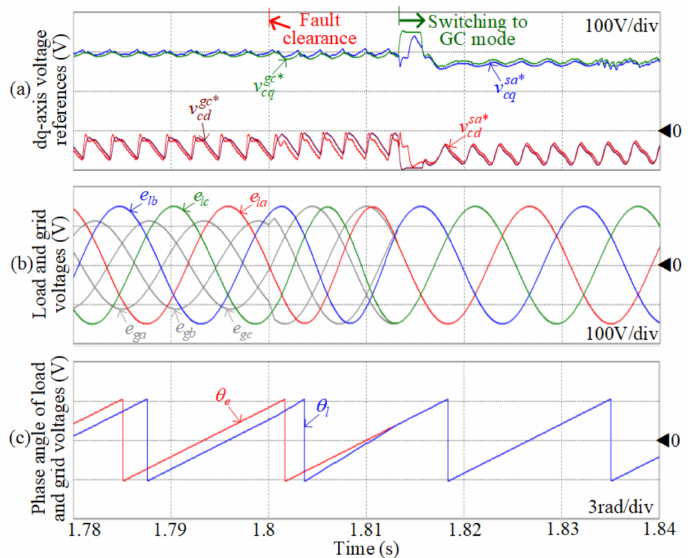
Figure 7. Transition performance from SA operation to GC operation: ( a ) dq -axis voltage references; ( b ) load and grid phase voltages; ( c ) phase angles.